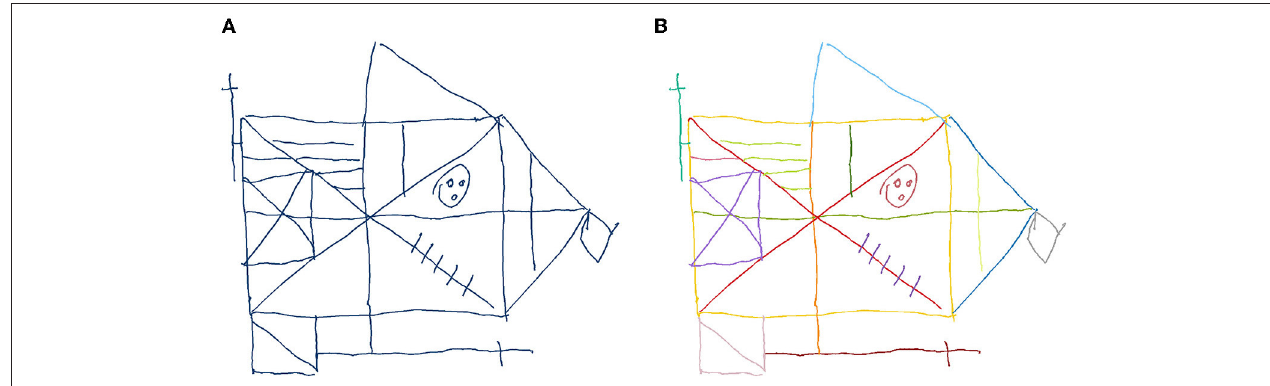
Frontiers in Artificial Intelligence |